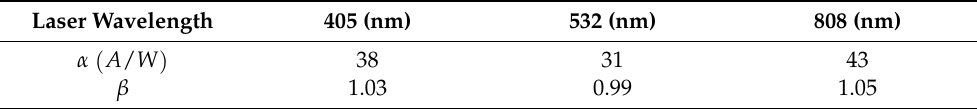
Table 1. List of the fitting parameters of the laser power-dependent photocurrent for three light wave-